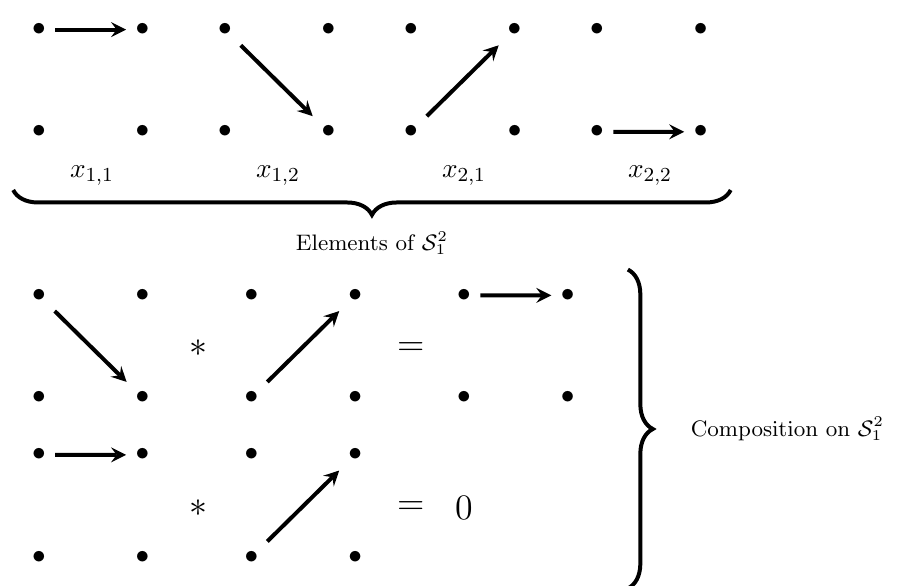
Figure 2 . Diagrammatic representation of S 2 . The composition rules are obtained by tracing 1 arrows connecting two elements. If one cannot trace a continuous arrow, the product is